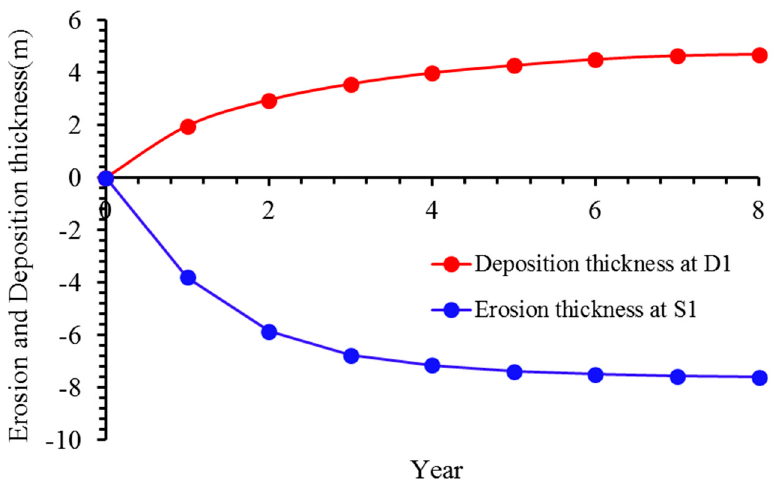
Figure 13. Erosion and deposition process accumulated year by year at sections D1 and S1. The locations of sections D1 and S1 are presented in Figure 12.